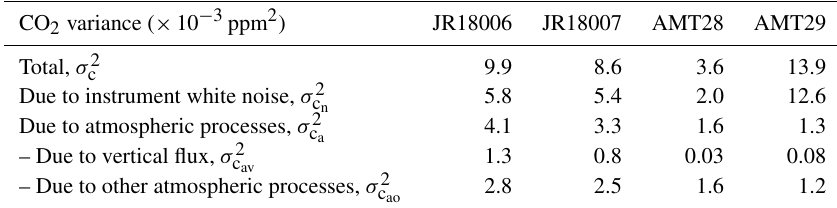
) and atmospheric processes ( σ 2 c ). The n a ) and due to other processes ( σ 2 c ao av